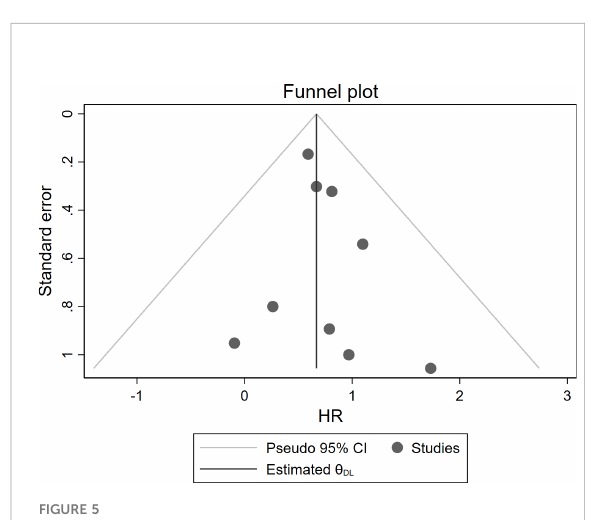
FIGURE 5 Funnel plot to assess publication bias of OS.